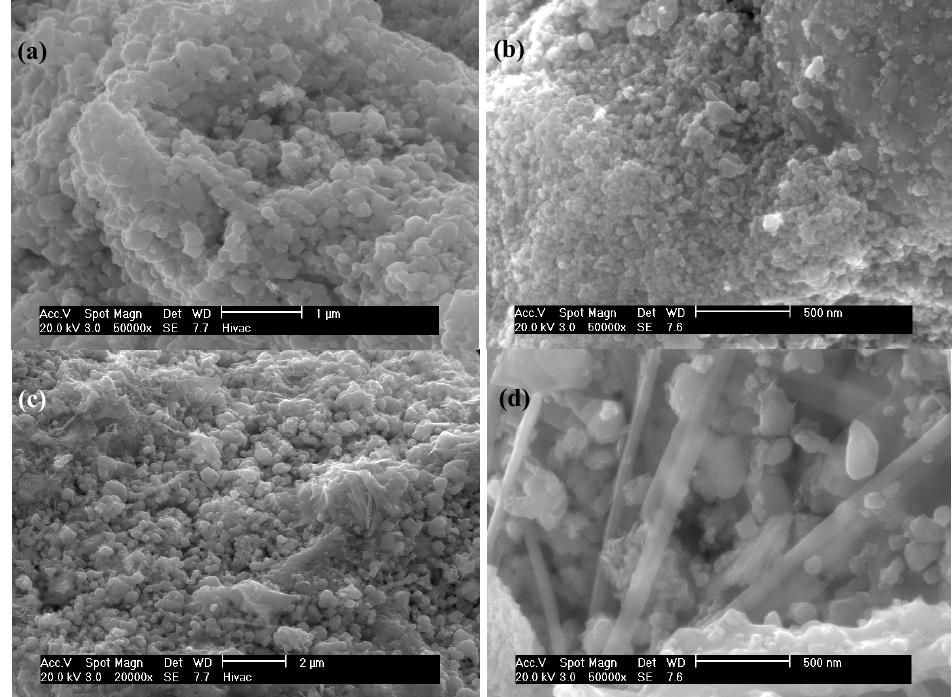
Figure 12. SEM images of samples involving H 100 nm ( a – c ), and the presence of nanotubes ( d